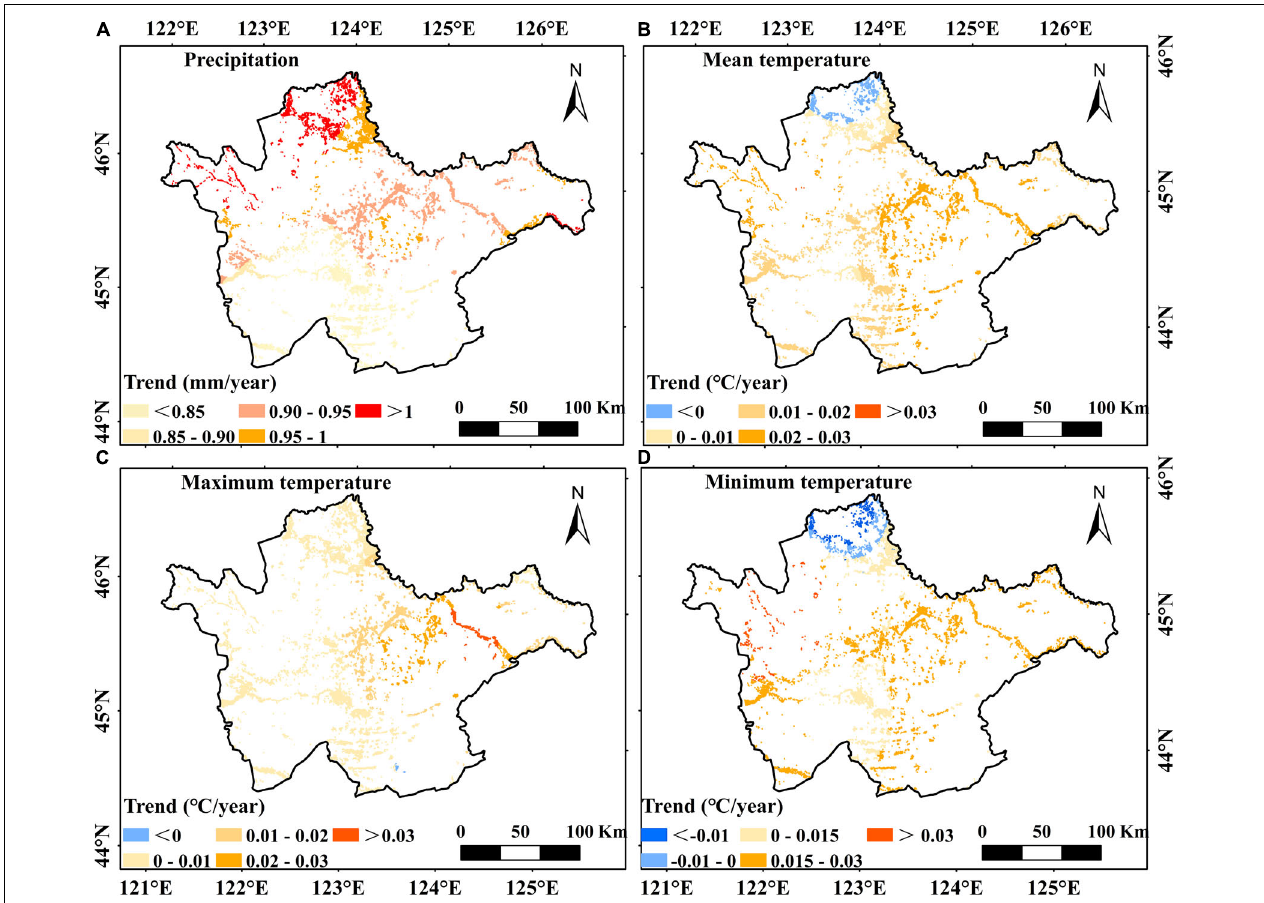
FIGURE 6 | Spatial change trends of annual precipitation (A) , annual mean temperature (B) , annual maximum temperature (C) , and annual minimum temperature (D) in the western Songnen Plain marshes during 2000–2020.